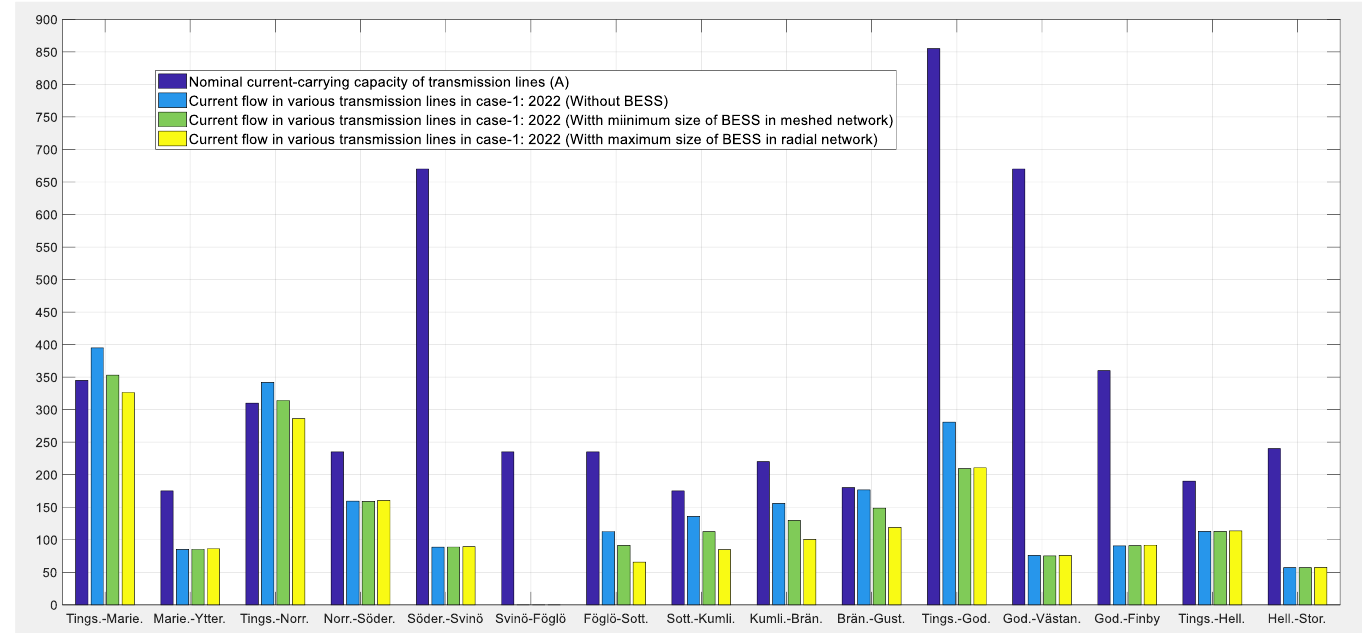
Figure 14. Nominal and actual current flows in transmission lines for the year 2022 with BESSs.